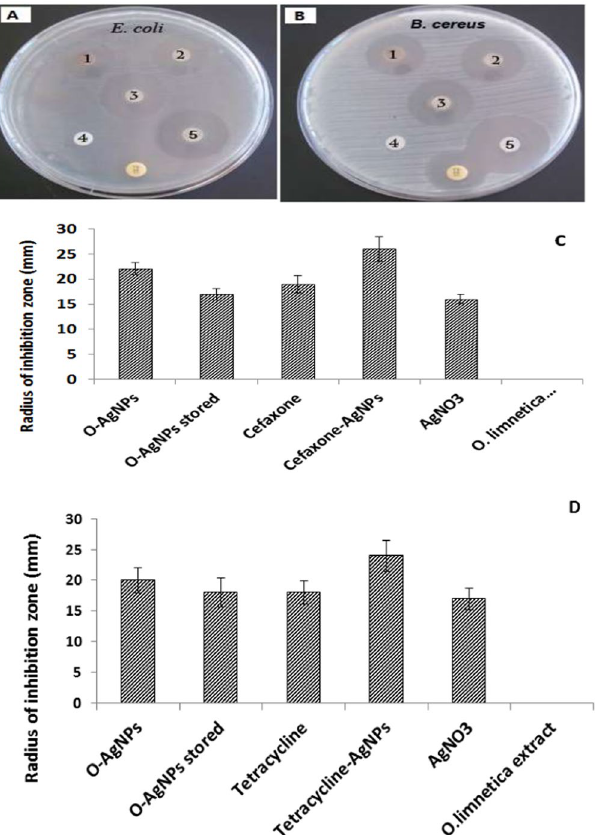
Figure 6. Antibacterial activity (zone of inhibition) of O-AgNPs against two human pathogenic bacteria E . coli ( A , C ) and B . cereus ( B , D ) where (1) is AgNO 3 , (2) O-AgNPs stored, (3) O-AgNPs, (4) is O . limnetica extract, (5) A is Cefaxone-AgNPs & (5) B is tetracycline-AgNPs and (6) A is Cefaxone & (6) B is